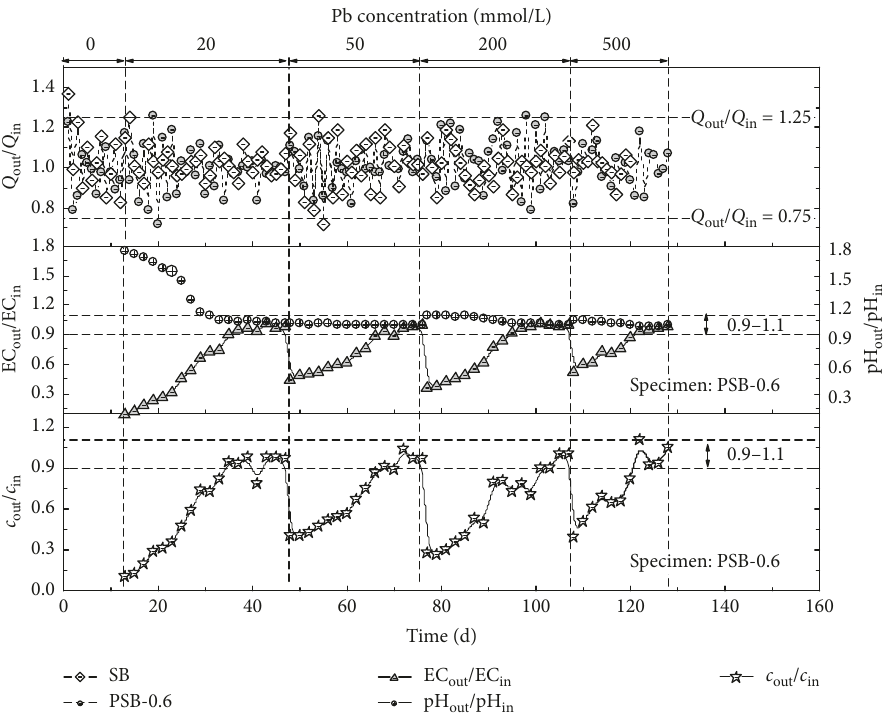
Figure 11: The chemical equilibrium condition of the flexible-wall permeability test.